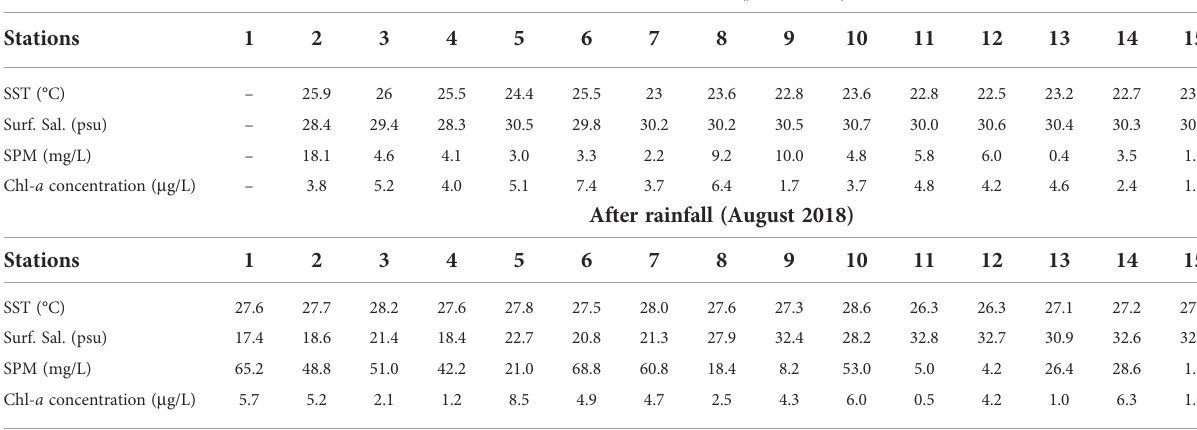
TABLE 2 Environmental variables in Yeosu Bay (each station) during June and August